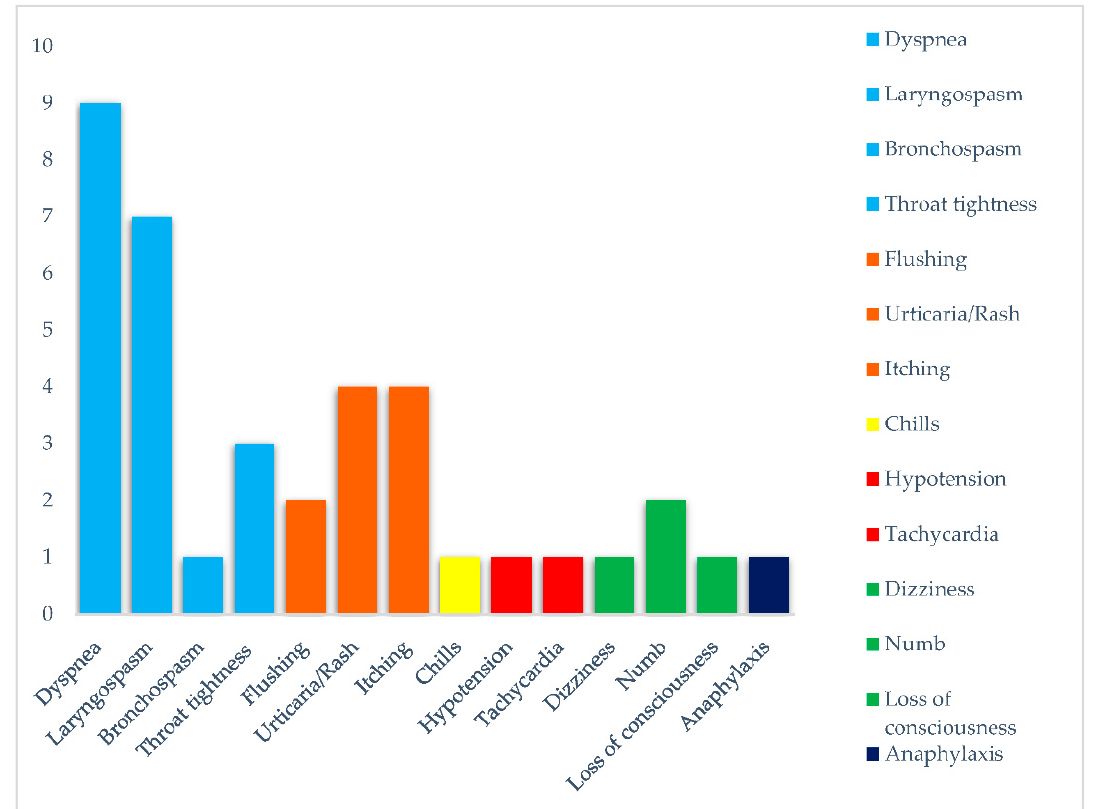
Figure 1. Symptoms of hypersensitivity to oxaliplatin.